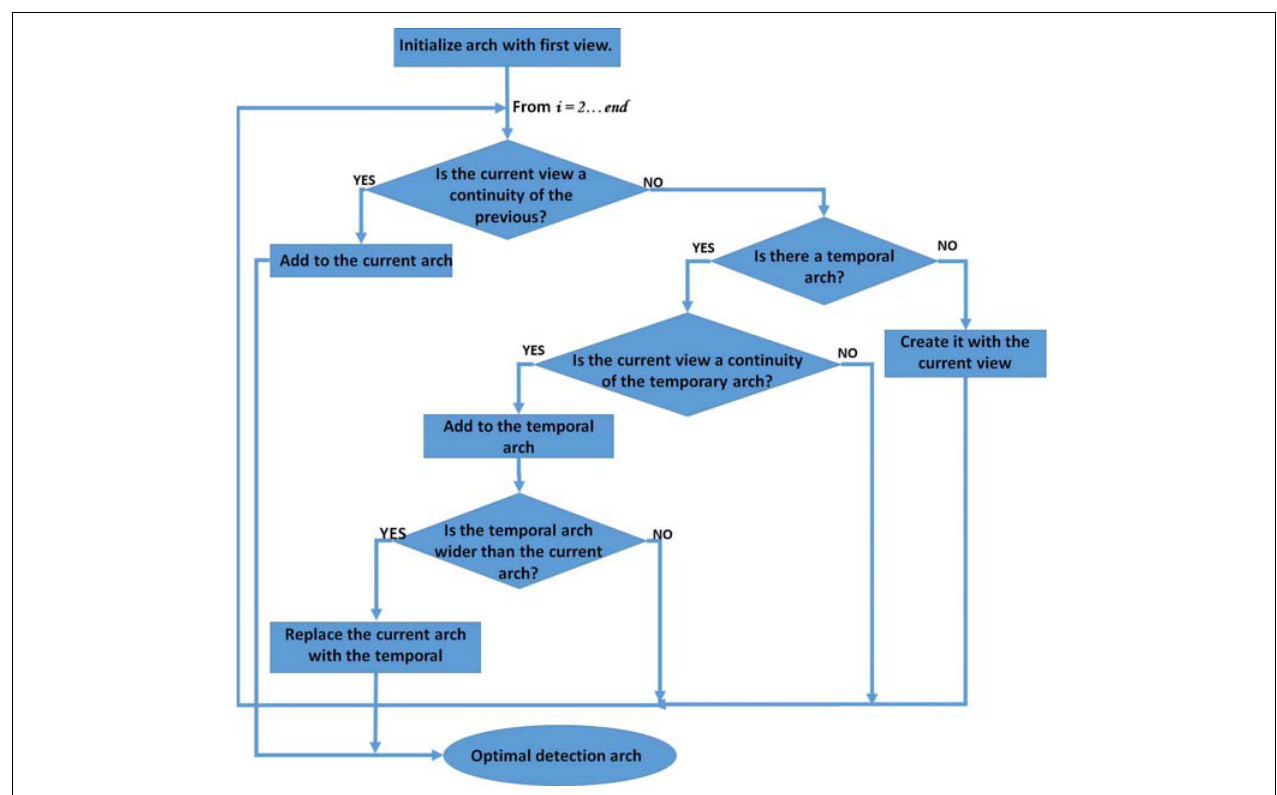
FIGURE 5 | General outline of the proposed algorithm to find the optimum detection